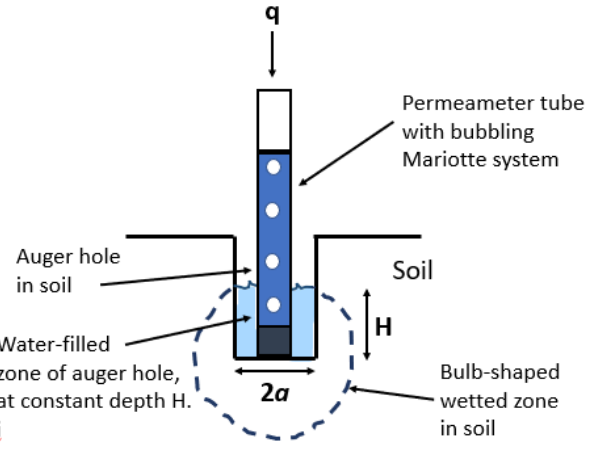
Figure 3. Schematic illustration of a well permeameter system.